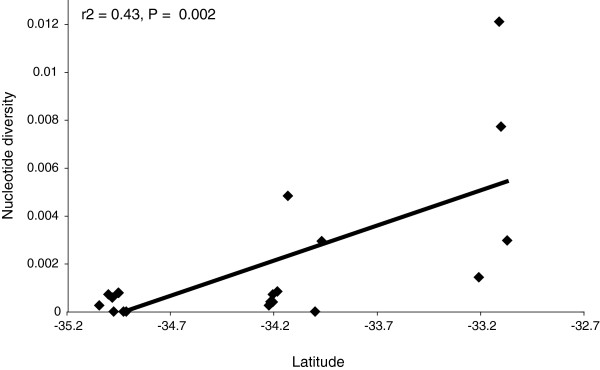
Phylogeny of the ND2 fragment of the gecko Oedura lesueurii in southeastern Australia, analysed using a maximum likelihood procedure. Values in branches are indices of support for the major branches for maximum likelihood (ML) and maximum parsimony (MP) analyses (percentage of 1000 replications for ML and MP).